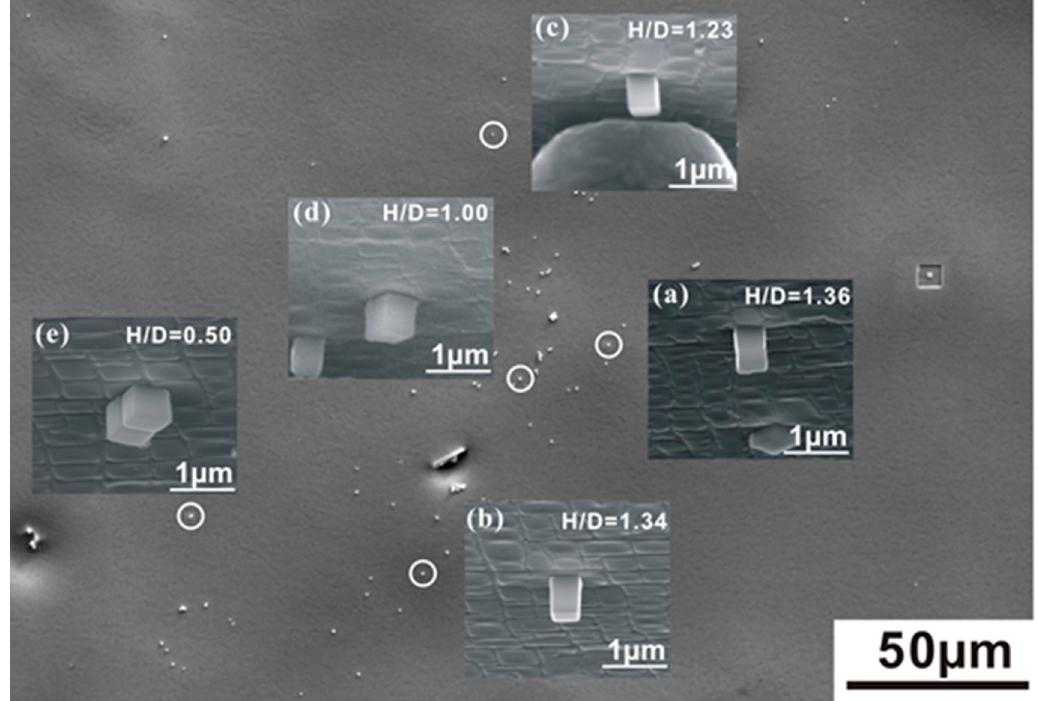
Figure 2. Cube-shaped nanoparticles with different aspect ratios in the size range of 300–500 nm which were isolated from the SX alloy ERBO-1 by selective phase dissolution. ( a ) height/weight (H/W) = 1.36; ( b ) H/W = 1.34; ( c ) H/W = 1.23; ( d ) H/W = 1.00; ( e ) H/W = 0.50.